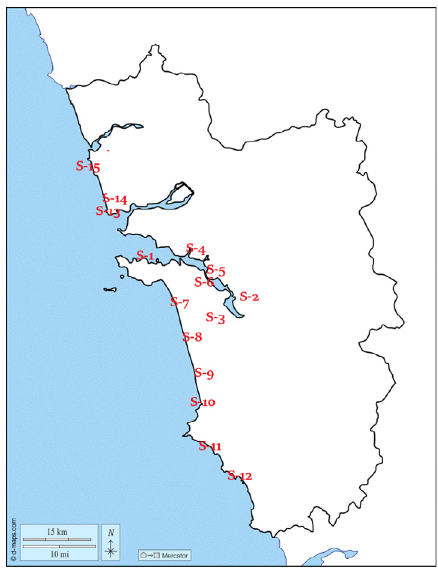
Fig. 1. Map illustrating the study area and sampling locations at coastline of Goa, India Sampling site code; S-1: Vasco, S-2: Borim, S-3: Rassai, S-4: Cortalim, S-5: Adpai, S-6: Zuari river, S-7: Arossim, S-8: Majorda , S-9 Betal batim, S-10: Colva , S-11- Khola, S-12: Sernabatim S-13: Miramar, S-14: Bogmalo S-15: